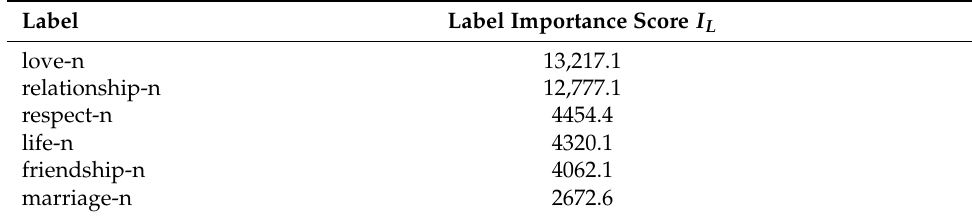
Label candidates for community FoF [ and | or ] love graph and restricted to FoF [ and | or ] love graph